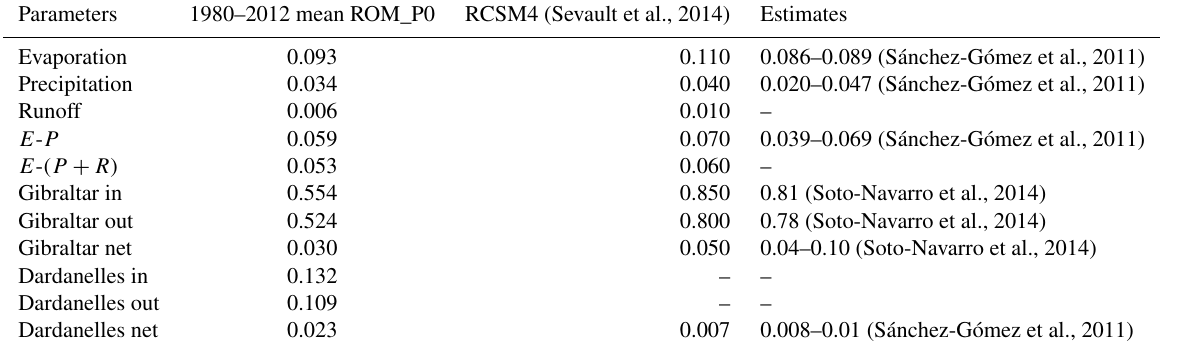
Table 4. Water balance and exchange flows for the Mediterranean Sea according to ROM_P0, RCSM4 and observation-based estimates. All results are presented in sverdrups (Sv).